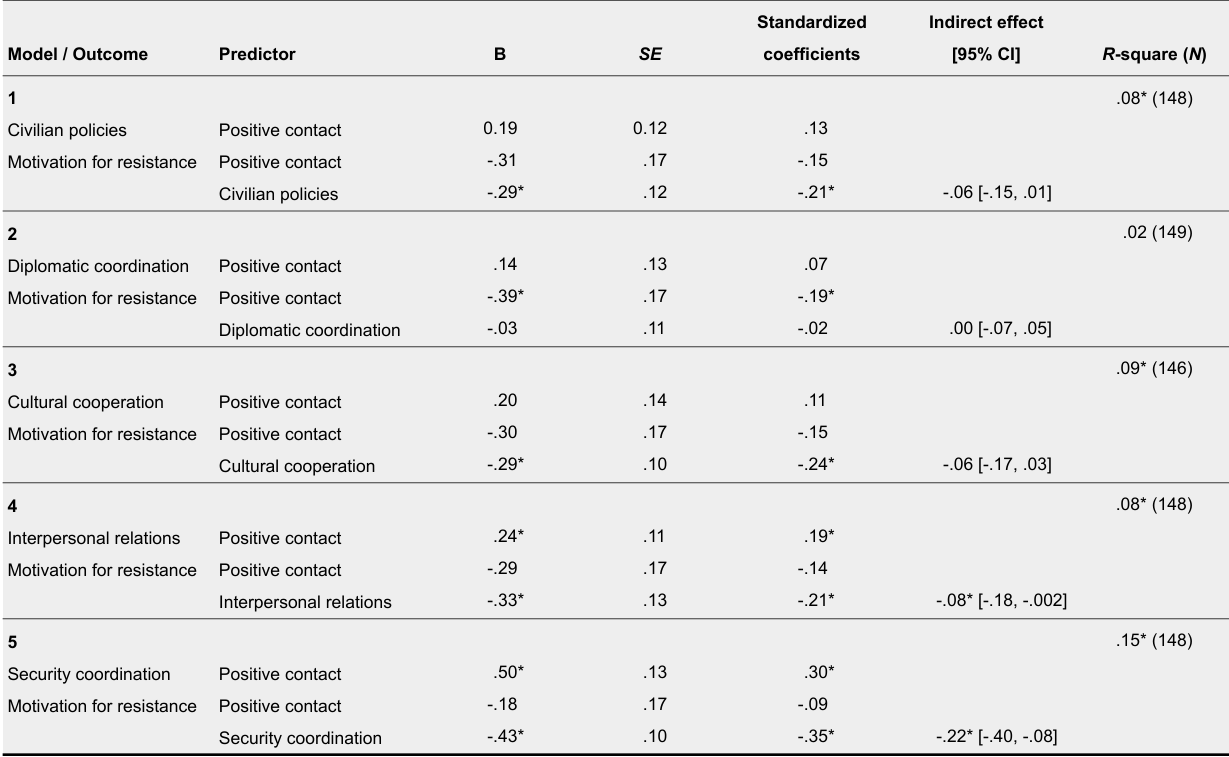
Path Analysis Using Multiple Regression